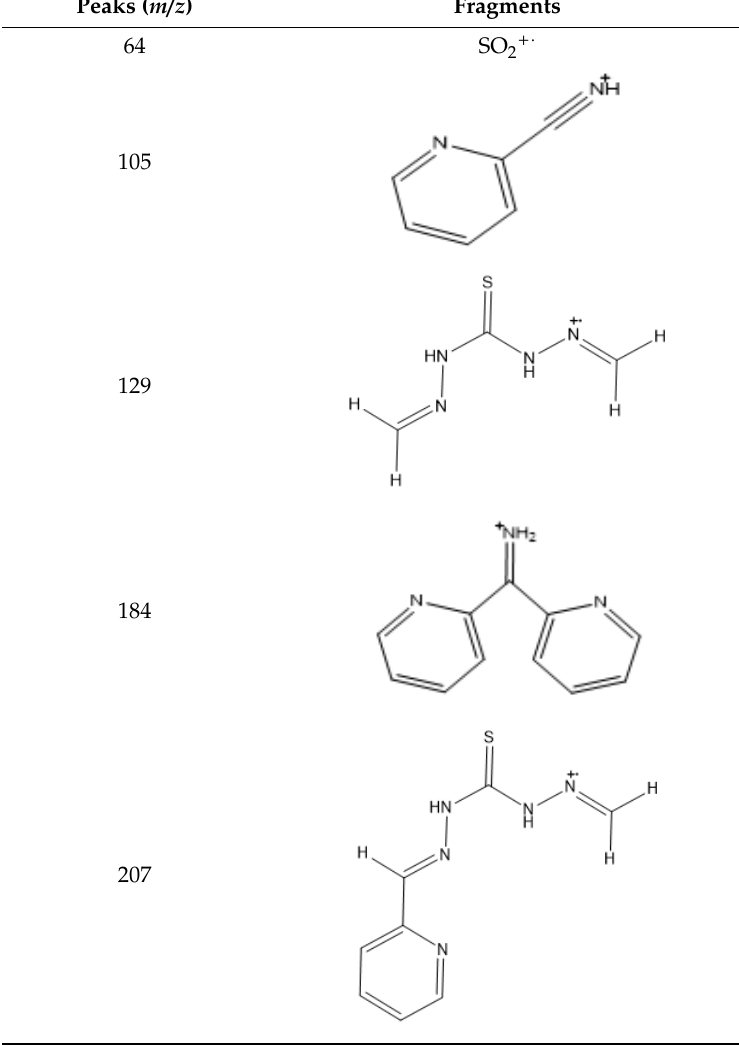
Table 3. MS spectra assignment of peaks.